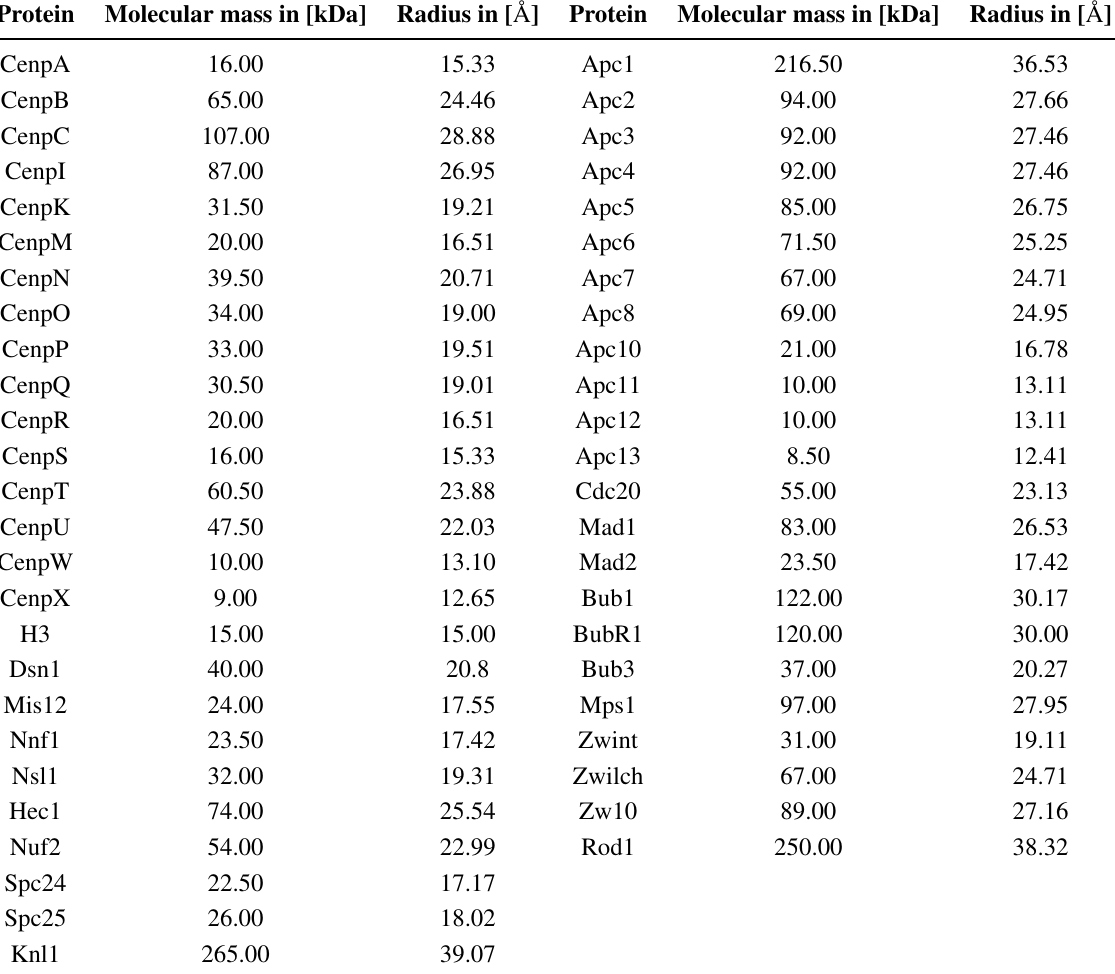
Table 5. Molecular geometry information . We derived the radius of simulation particles from the assumption that molecules are spheric and all have the same